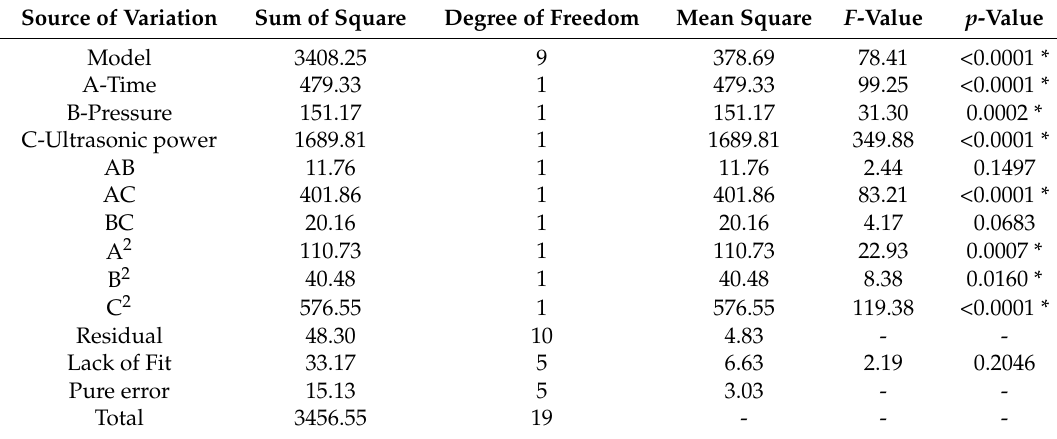
Table 5. The ANOVA results of pellet durability in a full model.